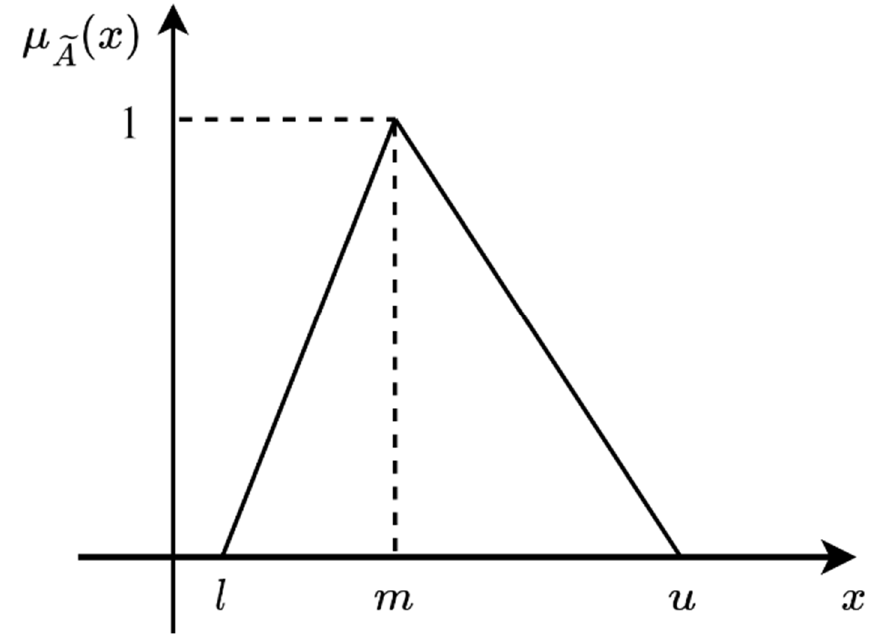
Figure 1. Diagram of TPN.